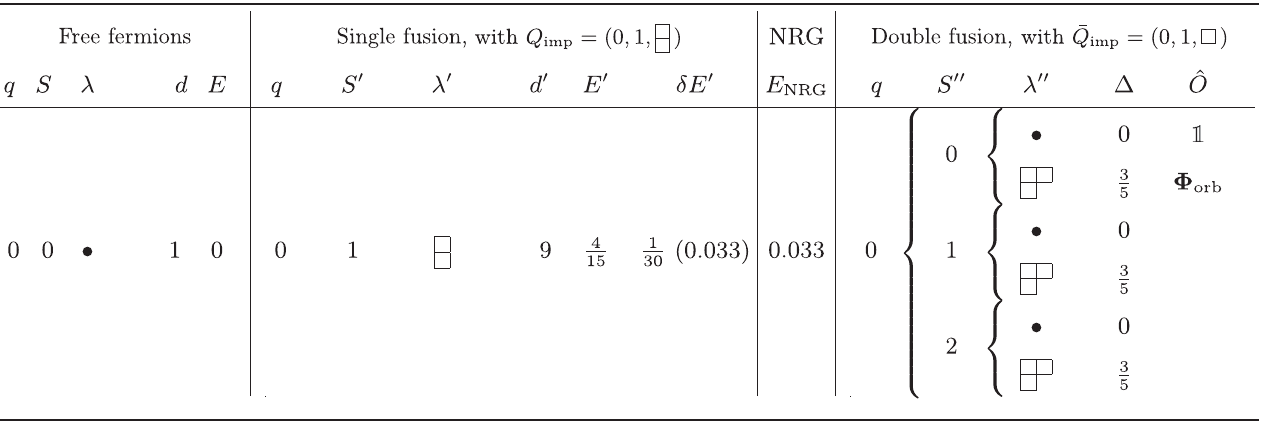
TABLE II. Fusion table for orbital screening at the NFL fixed point c (cid:4) of the 3soK model. Left: The 14 lowest low-lying free- NFL fermion multiplets ð q; S; λ Þ , with multiplet dimensions d and energies E ð q; S; λ Þ , computed using Eqs. (12) and Table S1 of the SM [54]. Center: Single fusion with a Table S2 of the SM [54]) in the orbital sector. This yields multiplets ð q; S 0 ; λ 0 Þ , with dimensions d 0 , energies E 0 ¼ E ð q; S; λ 0 Þ , and excitation energies δ E 0 ¼ E 0 − E 0 . These are compared to the values, E , computed by NRG for ð J 0 ; K 0 ; I 0 Þ ¼ ð 0 ; 0 . 3 ; 0 Þ . The NRG NRG min energies have been shifted and rescaled such that the lowest energy is zero and the second-lowest values for E and δ E 0 match. The NRG single-fusion and NRG spectra agree well (deviations ≲ 10% ). Right: Double fusion, which fuses multiplets from the middle column ¯ Q 0 ; 1 ; □ Þ , yields the quantum numbers ð q; S 00 ; λ 00 Þ . These characterize the CFT with an impurity in the conjugate representation imp ¼ ð ˆ O boundary operators , with scaling dimensions Δ ¼ E ð q; S; λ 00 Þ